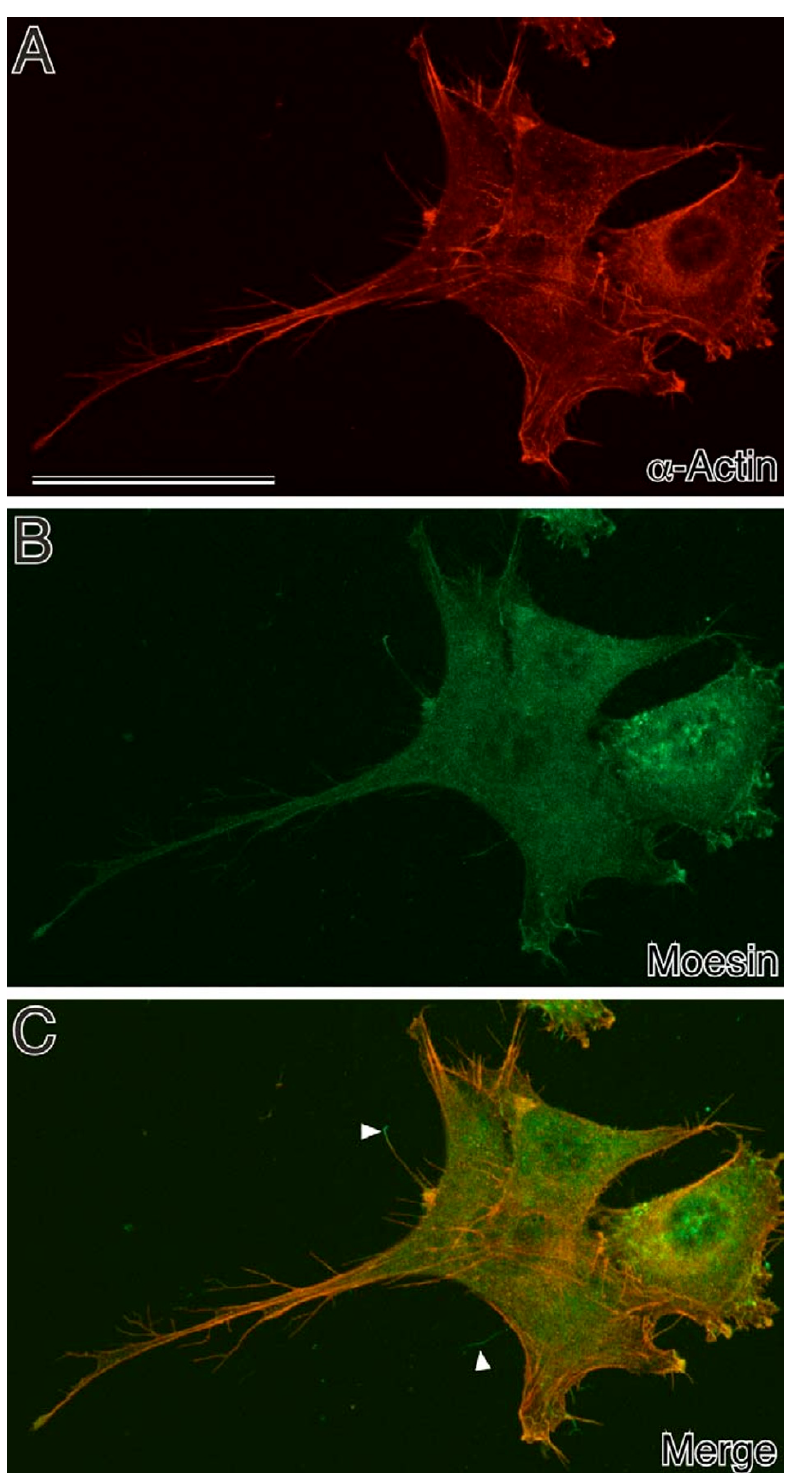
Figure 5 Double staining of actin and moesin in NIH3T3 cells fixed with DOTMAC/PFA shown at high magnification. Note that branched micropodia were well preserved by the DOTMAC/PFA fixative and stained with both β -actin monoclonal and moesin polyclonal antibodies. Some of the moesin-positive micropodia were β -actin-negative (arrowhead). Bars, 50 µ